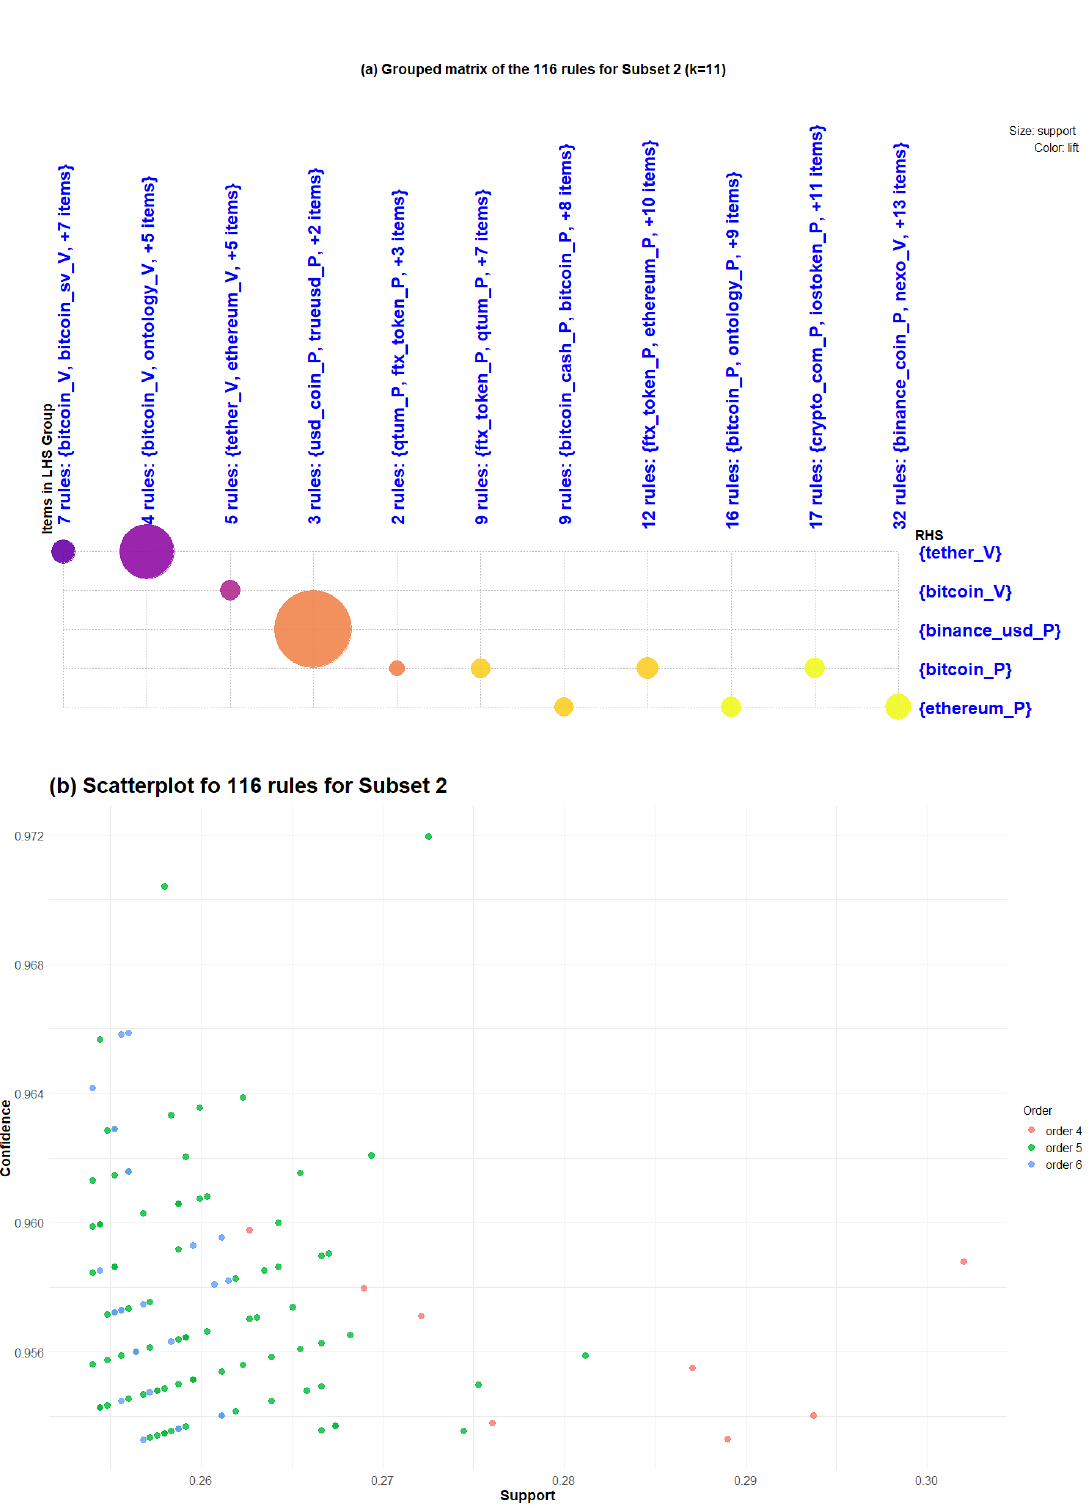
Figure 5. ( a ) Group matrix-based plot for 116 rules of Subset 2 with k = 11 groups, ( b ) Scatter plot of the rules for Subset 2 colored by order (LHS +